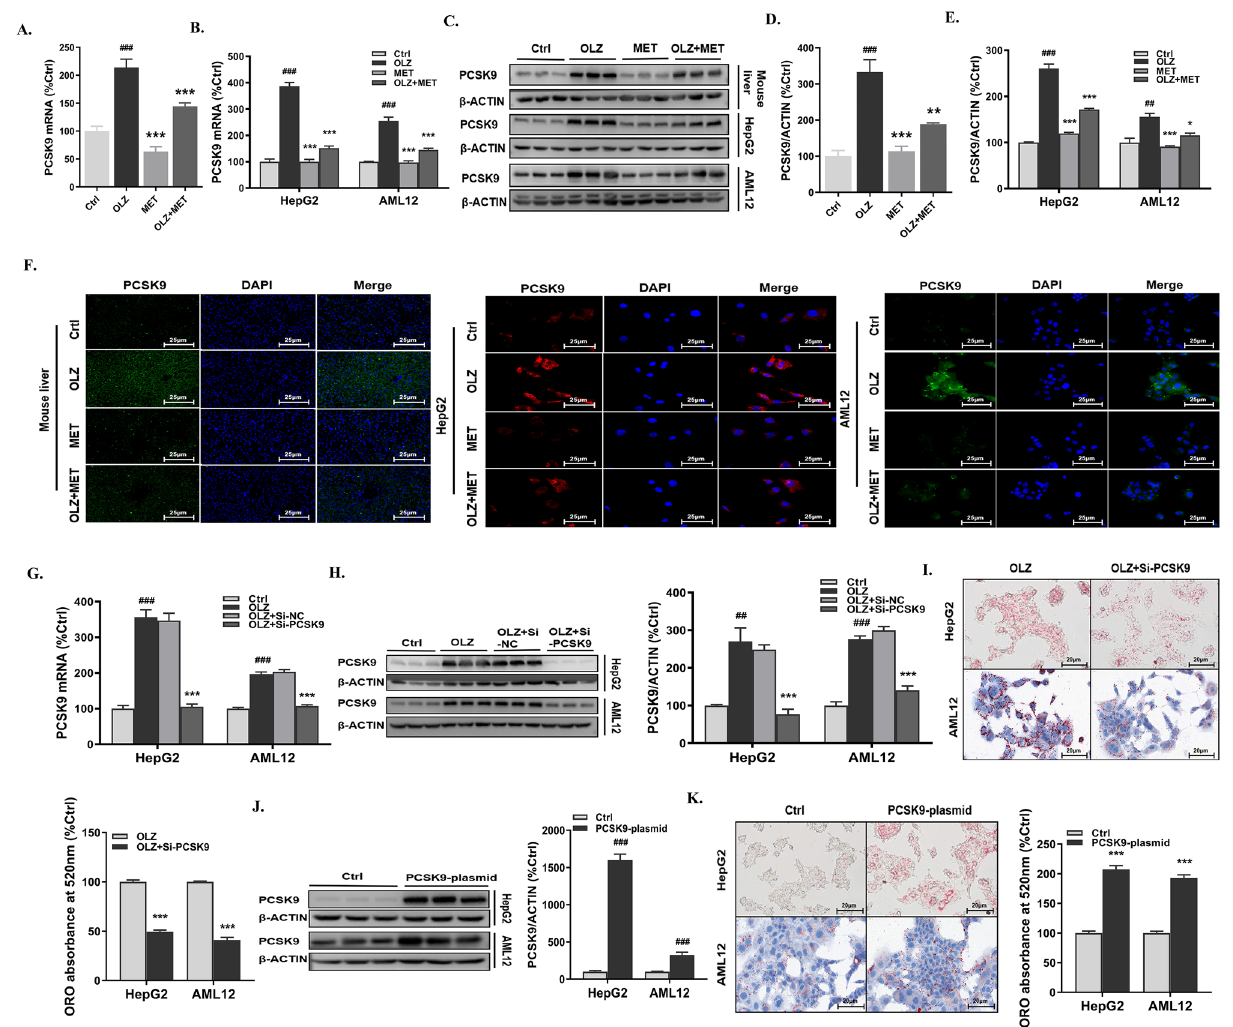
Figure 2. Olanzapine-associated hepatic steatosis is associated with elevated PCSK9 levels. PCSK9 mRNA in ( A ) mouse liver tissues, ( B ) HepG2 cells and AML12 cells. ( C-E ) PCSK9 protein levels in mouse liver tissues, HepG2 cells and AML12 cells. ( F ) Immunofluorescence staining of PCSK9 in mouse liver tissues, HepG2 cells and AML12 cells. PCSK9 ( G ) mRNA and ( H ) protein levels in HepG2 cells and AML 12 cells treated with si-PCSK9. ( I ) ORO staining of HepG2 cells and AML 12 cells treated with si-PCSK9. ( J ) PCSK9 protein levels in HepG2 cells and AML 12 cells treated with the PCSK9 plasmid. ( K ) ORO staining of HepG2 cells and AML 12 cells treated with the PCSK9 plasmid. Ctrl, control; OLZ, olanzapine; MET, metformin; Si-PCSK9, PCSK9 siRNA. Data represent the mean ± SEM. ## p < 0.01, ### p < 0.001 vs. control; ** p < 0.01, *** p < 0.001 vs. olanzapine; Student’s two-tailed t -test and one-way ANOVA plus Tukey’s post-hoc